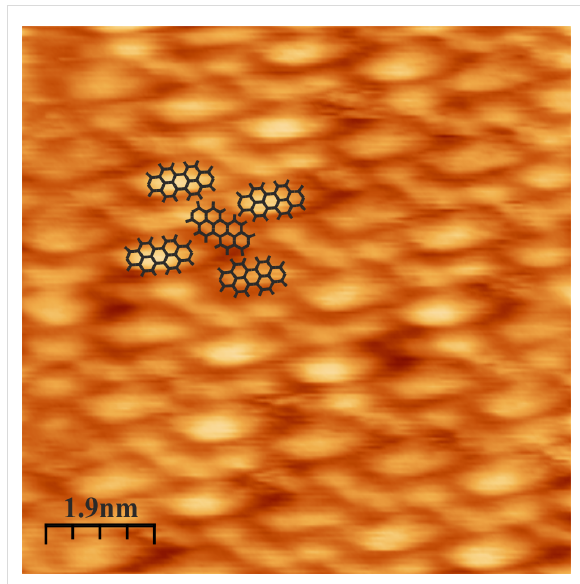
Figure 2: STM image of a double layer of PTCDA arranged in a herringbone phase. The structure is indicated by the schematic drawing of molecular lattice. Scan area: 9 nm × 9 nm; tunneling voltage U = 1 V; tunneling current I = 60